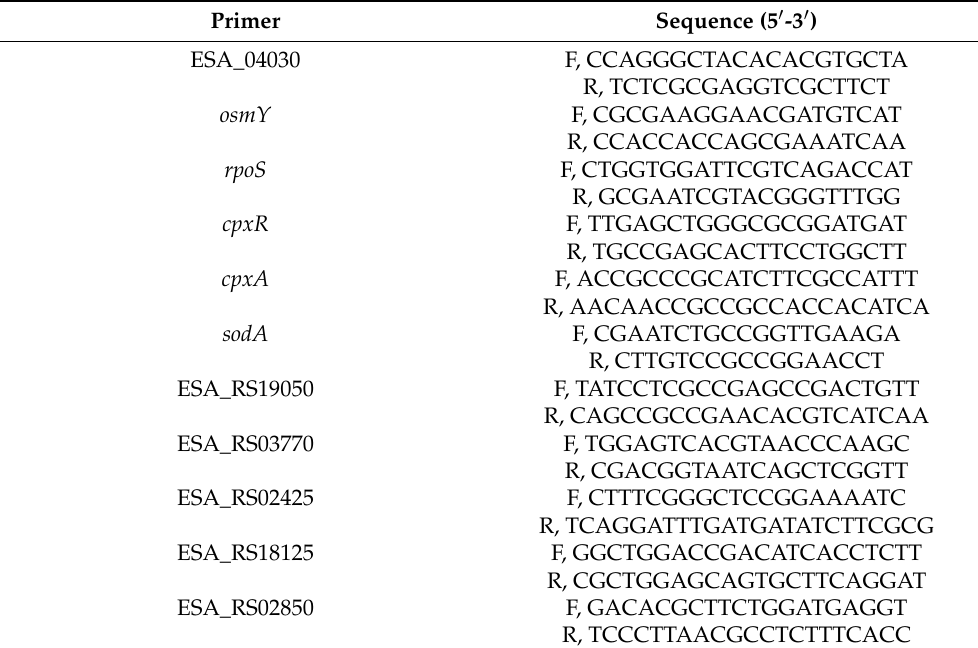
Table 3. Primers that were used for RT-qPCR analysis in this